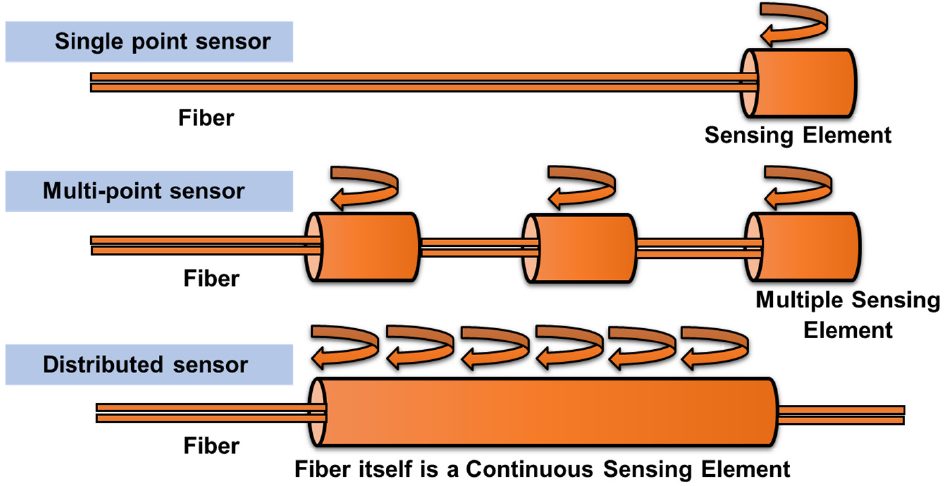
Figure 9. Schematic diagram of three FBG Sensors.